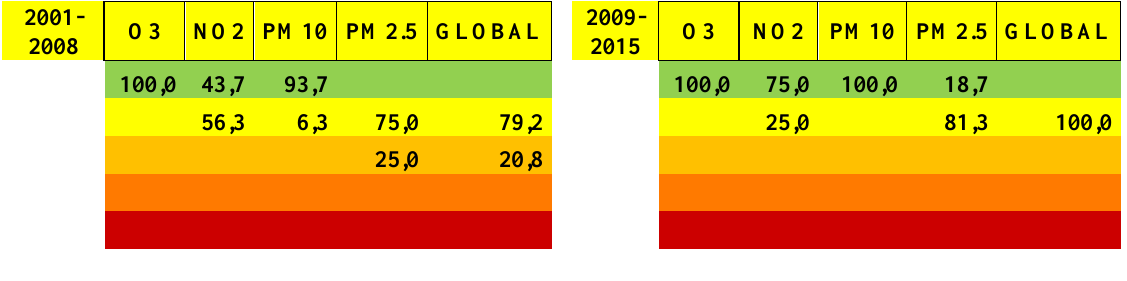
Table 3. Percentage of months with a given air quality in